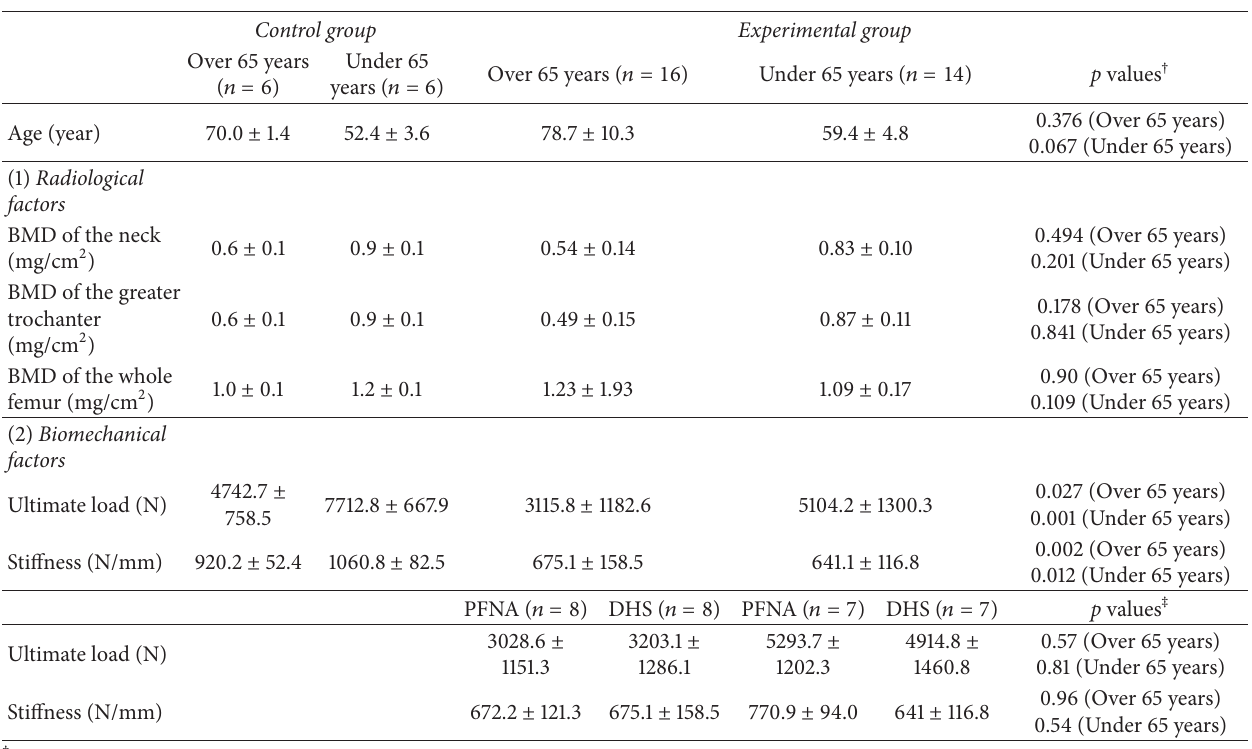
Table 2: Radiological and biomechanical data between the specimen over and under 65 years.